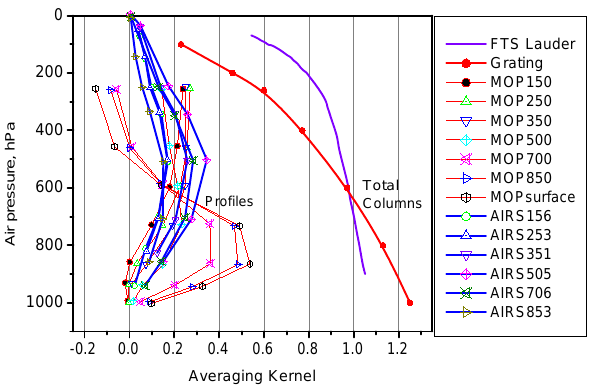
Fig. 1. Examples of averaging kernels for interferometer BRUKER IFS 120HR installed in Lauder, New Zealand (Rinsland et al., 2002), grating spectrometer in Zvenigorod, Russia (Yurganov et al., 2002), MOPITT V3 (Deeter et al., 2004) for 9 September 2000, over the tropical Atlantic, red lines, and AIRS V5 (30 August 2006, 40.1 ◦ N, 95.6 ◦ W), blue lines. Designation MOP150 means averag- ing kernel for 150hPa level,